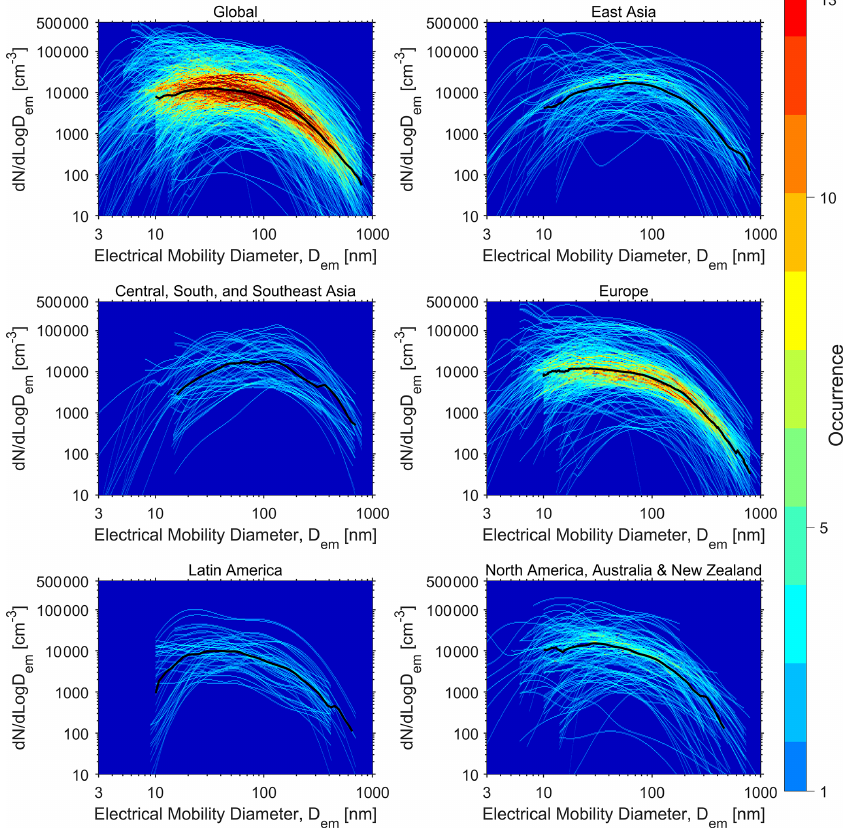
Figure 6. Urban aerosol number PSDs analyzed in this study, grouped by geographical region. The figure incorporates all submicron number PSDs measured by electrical mobility-based techniques (624 PSDs). The color represents the occurrence frequency of the number PSDs at a given particle size with a certain concentration. The black lines indicate the median number PSDs in each group.